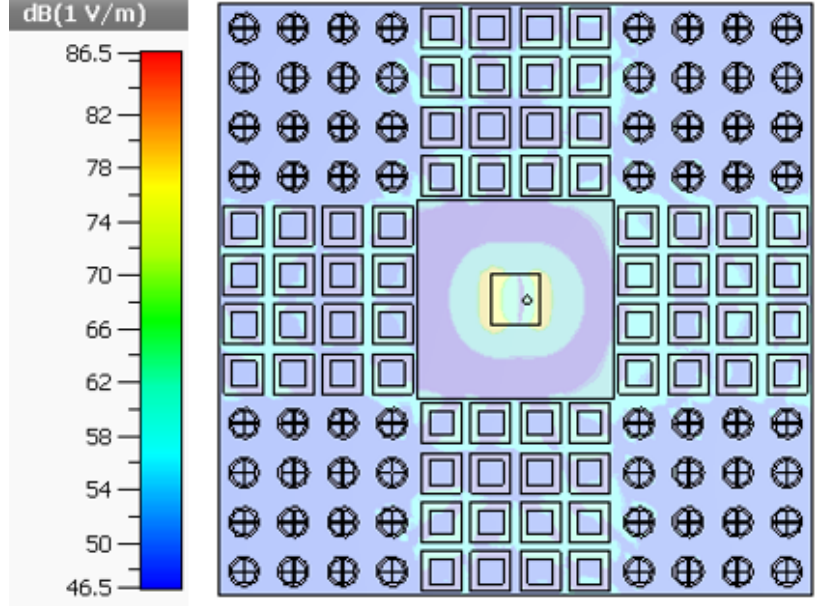
Figure 7. E-field distribution of maximum in-band radar cross-section (RCS) reduction at 7.6 GHz.